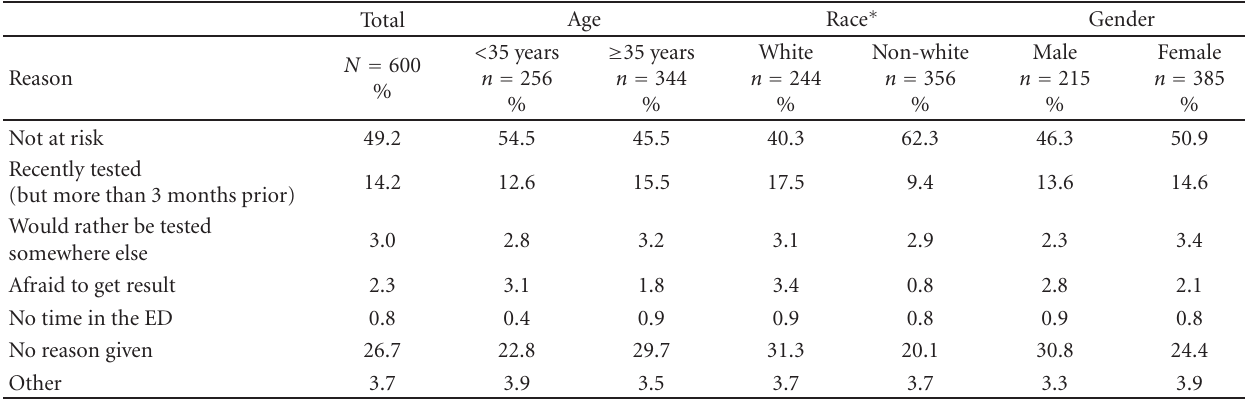
Table 2: Reason for declining an HIV